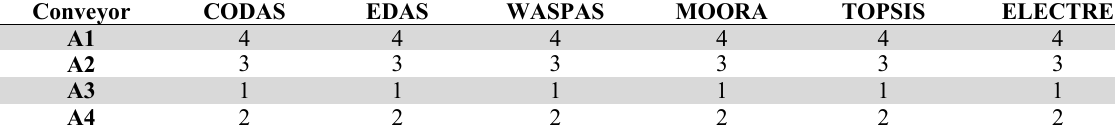
CODAS EDAS WASPAS MOORA TOPSIS